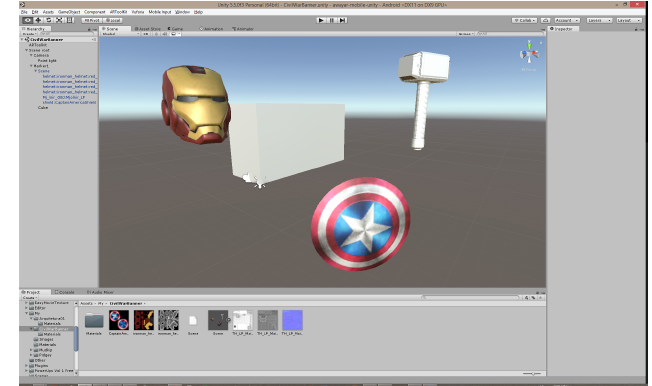
Figure 14. Scene being edited on Unity application. The big gray box on the center of the image represents the position in which the marker will appear over the TV in the real